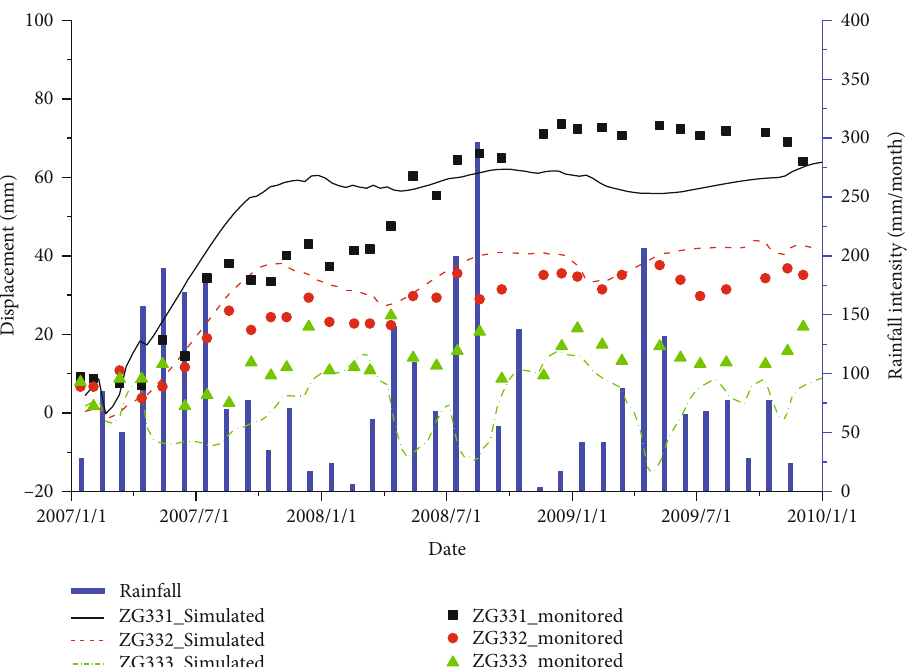
Figure 10: Evolution of the ground displacement and comparison with monitored